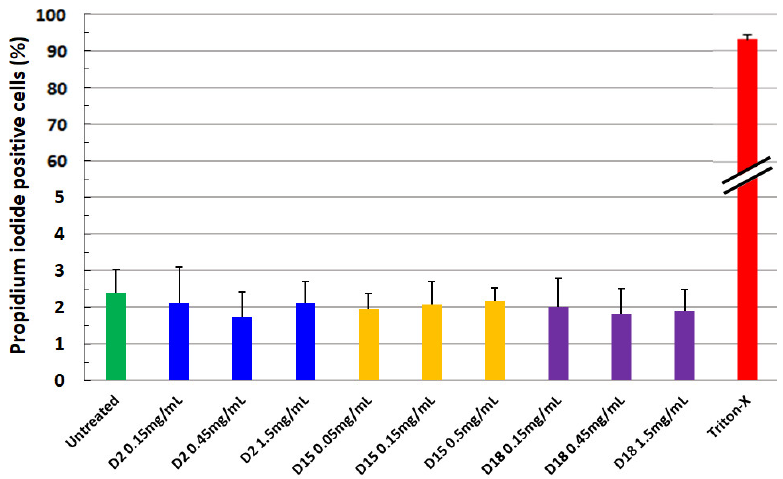
Figure 4. Cytotoxic activity of the three killer toxins (D2, D15, D18) against human intestinal cells (Caco-2 cells) measured as incorporation of propidium iodide (PI) into DNA of dead cells. Mean ± SEM of four experiments in duplicates.